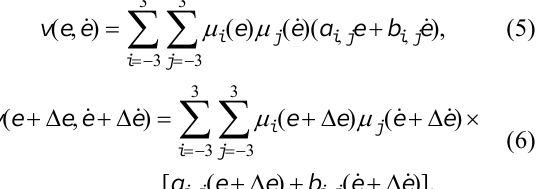
Fig. 2. Membership functions of i E